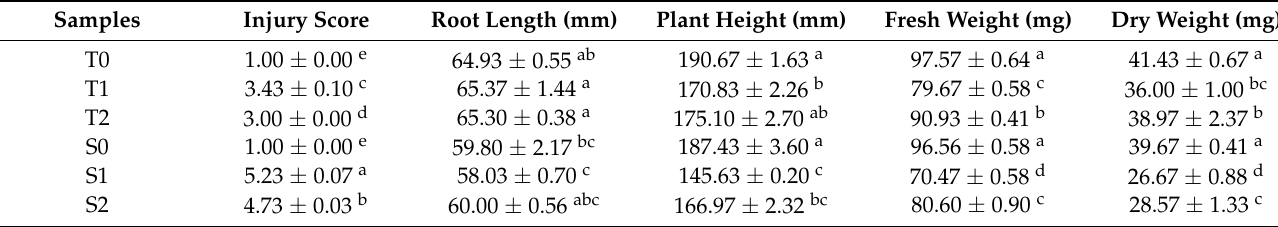
Table 1. Phenotypic responses of rice under salt stress.